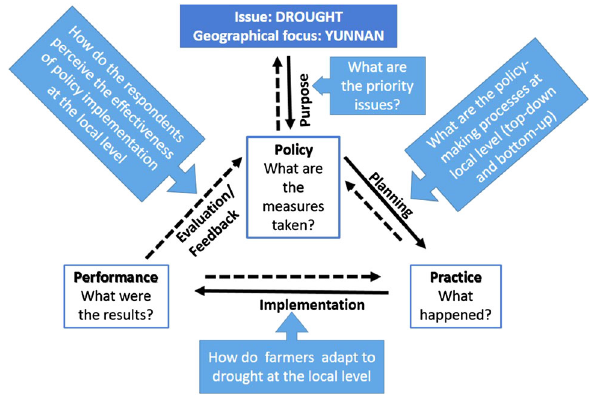
Fig. 2 Modified framework to analyze the effectiveness of policy implementation. Source Modified framework based on the concept presented by Sadler’s ‘‘effectiveness triangle’’ and Baker and McLelland’s ‘‘circular effectiveness cycle’’; literature review and field